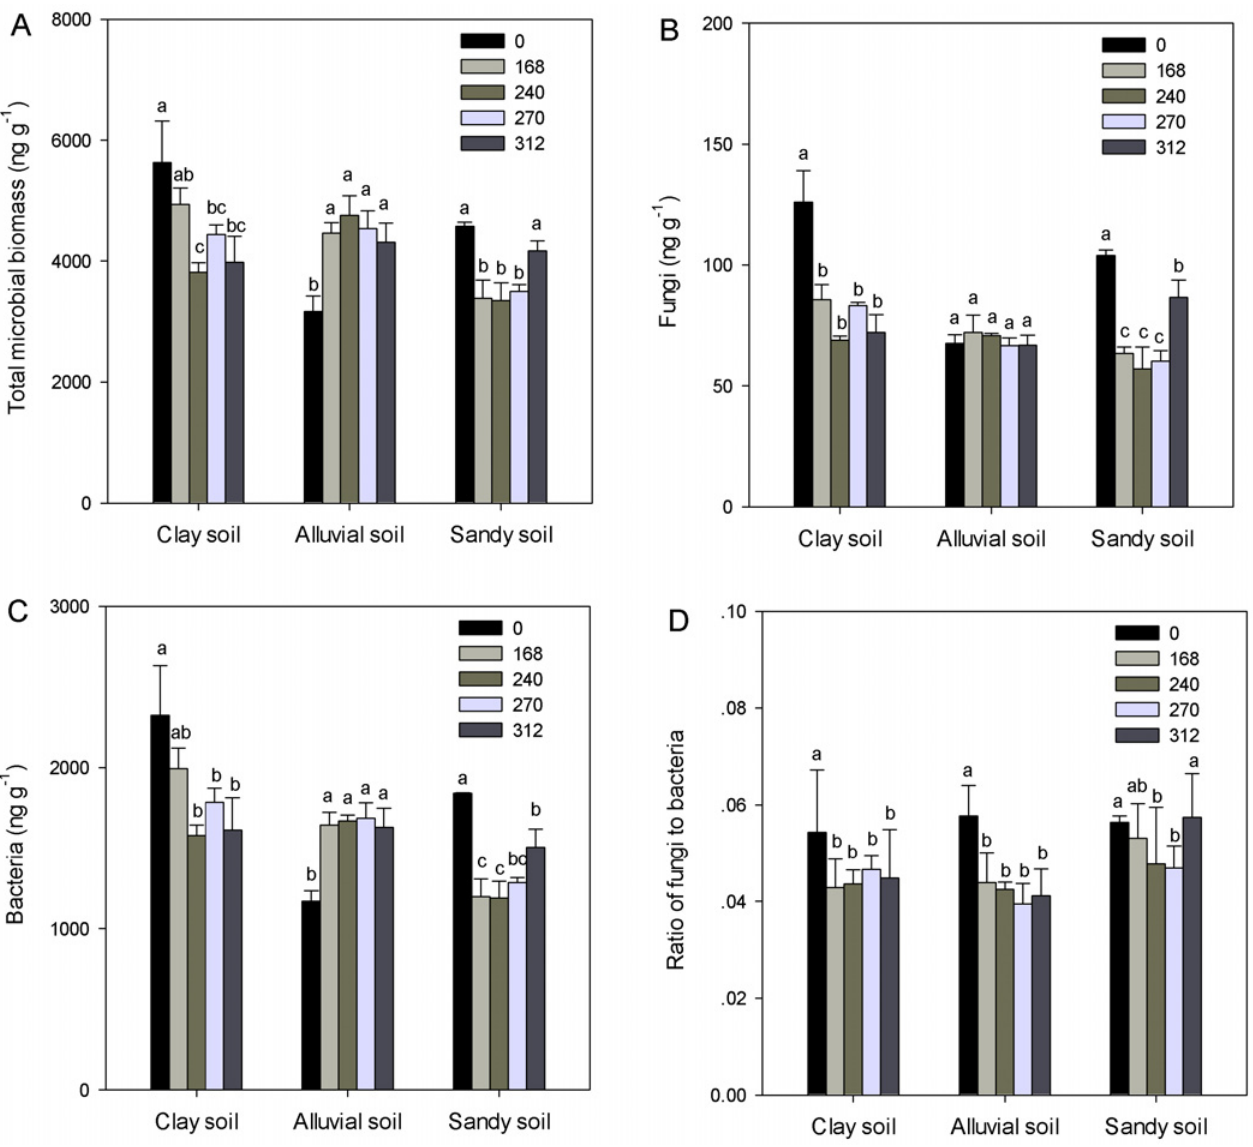
Fig 1. Concentrations of total microbial biomass (A), fungi (B) and bacteria (C), and ratios of fungi to bacteria (D) in three soils under application of N fertilizers at five rates (0, 168, 240, 270 and 312 kg N ha -1 ). Error bars indicate standard errors. Different letters within each soil indicate significant differences among N fertilization